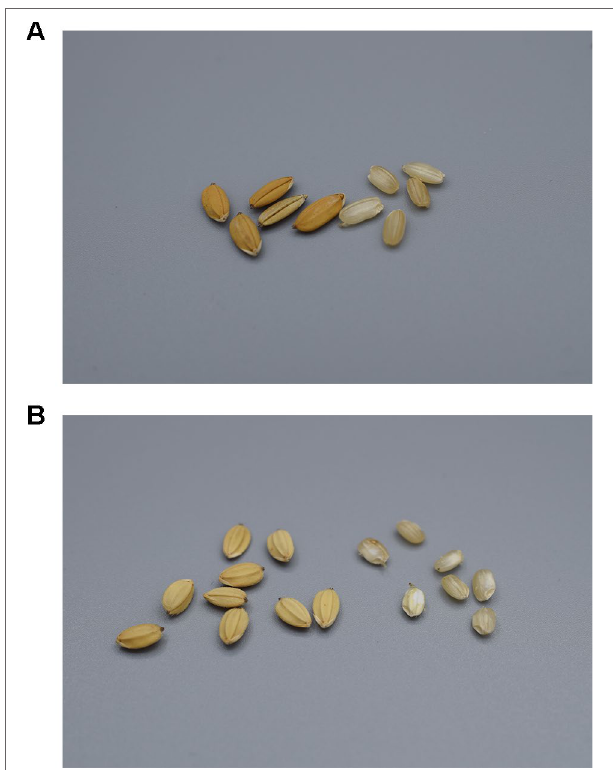
FIGURE 6 | Two shattering varieties of Maroon rice named ‘Alulu’ with husked (left) and dehusked (right) grains. (A) ‘White type’ with straw- coloured, pubescent, black-tipped husks (nr. 6772A) and (B) ‘Red type’, with orange-brown, glabrous, black-tipped husks (nr. 6819). Pictures by Alice